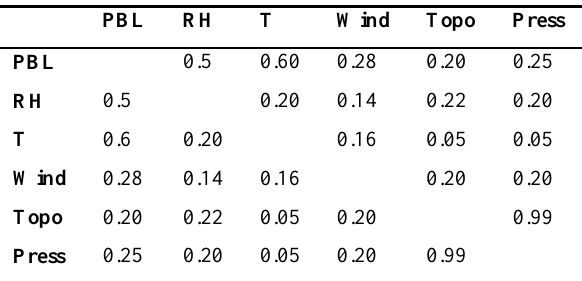
Table 1. Correlation between explanatory variables used in GWR model